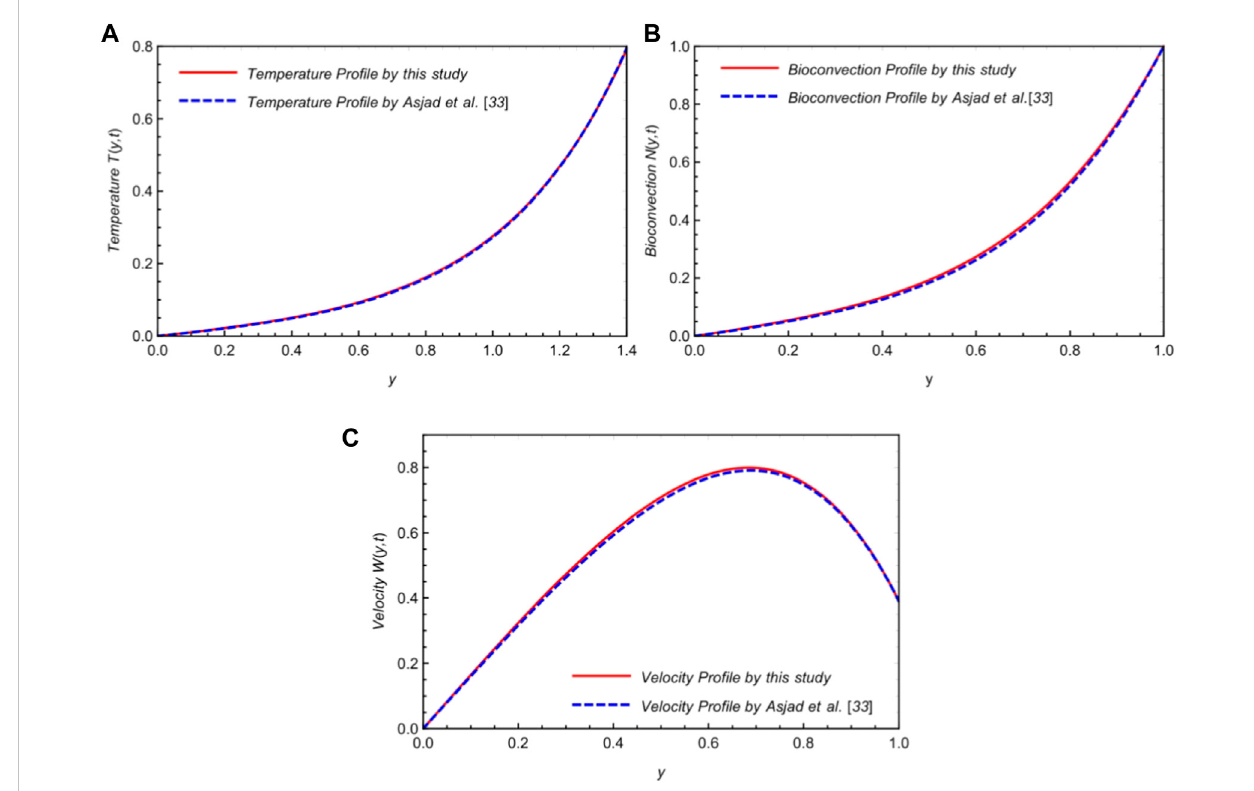
FIGURE 14 Comparison of the validity of governed equations with the attained results of Asjad et al.